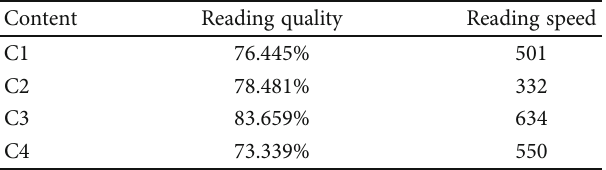
Table 1: AI-based reading versus traditional